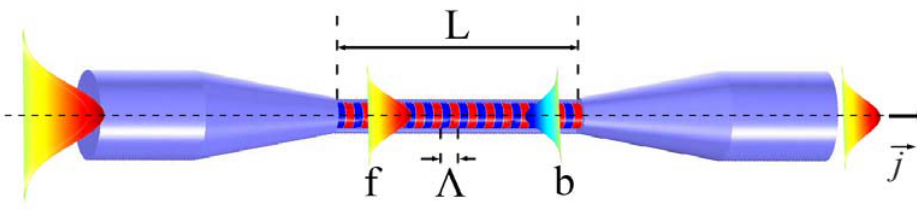
Figure 1. Schematic illustration of an uMFBG. The alternated red and blue stripes represent the refractive index modulation induced by photosensitization treatment. L and Λ are the grating length and period, respectively. f/b represent forward/backward propagating